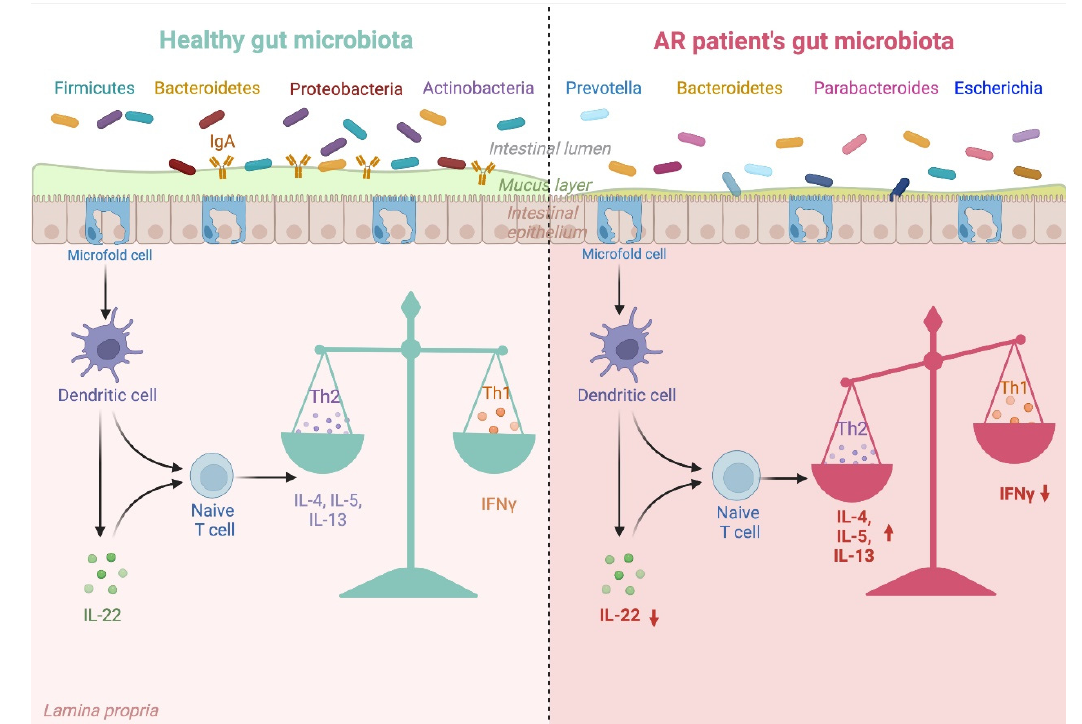
Figure 2. Gut microbiota dysbiosis in AR patients and its impact on Th1/Th2 balance. Gut microbiota composition differs between healthy individuals and AR patients. Gut microbiota typical for AR promotes unfavourable changes in cytokines, which promote the Th1/Th2 imbalance involved in AR development. Created with biorender.com, accessed on 24 September 2022